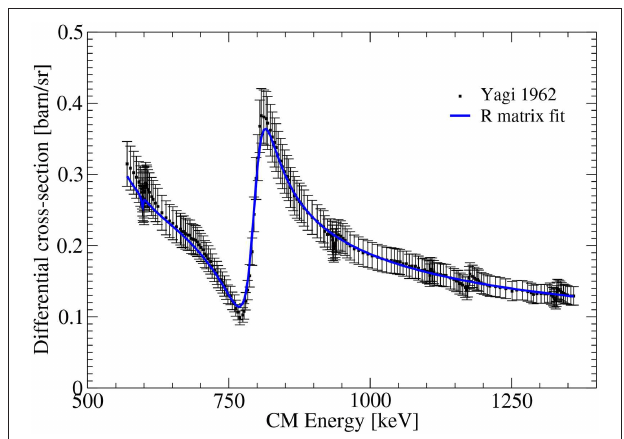
FIGURE 6 | 18 O(p,p) 18 O differential cross section at θ = 140 ◦ with the R -matrix fit. The data are taken from Yagi (1962). Reprinted from Bruno et al. (2019) with permission from Elsevier.